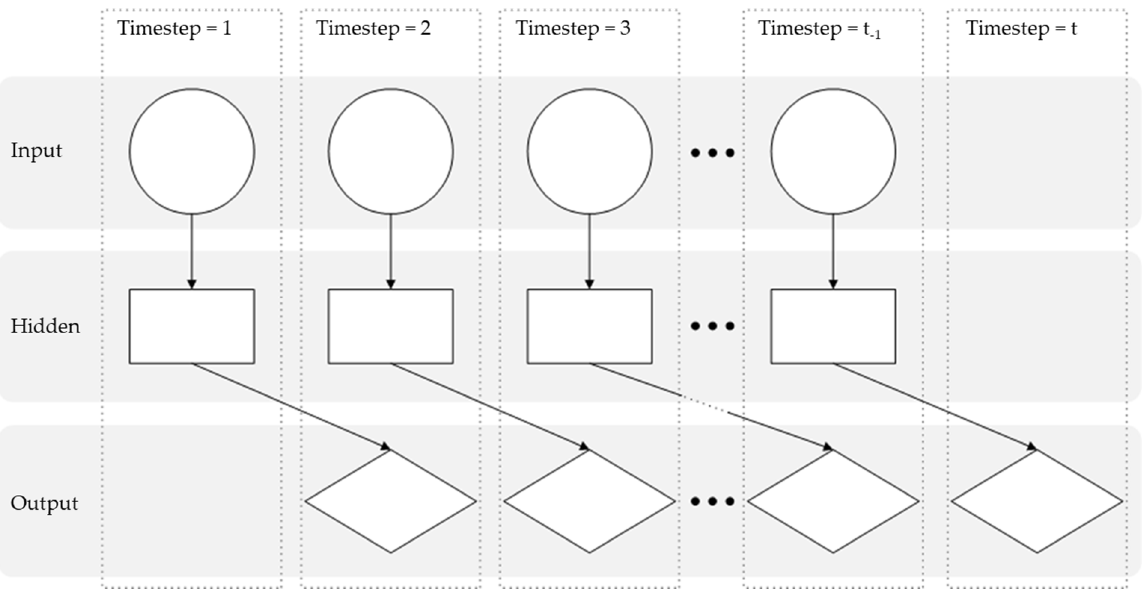
Figure 4. Schematic ANN model design.